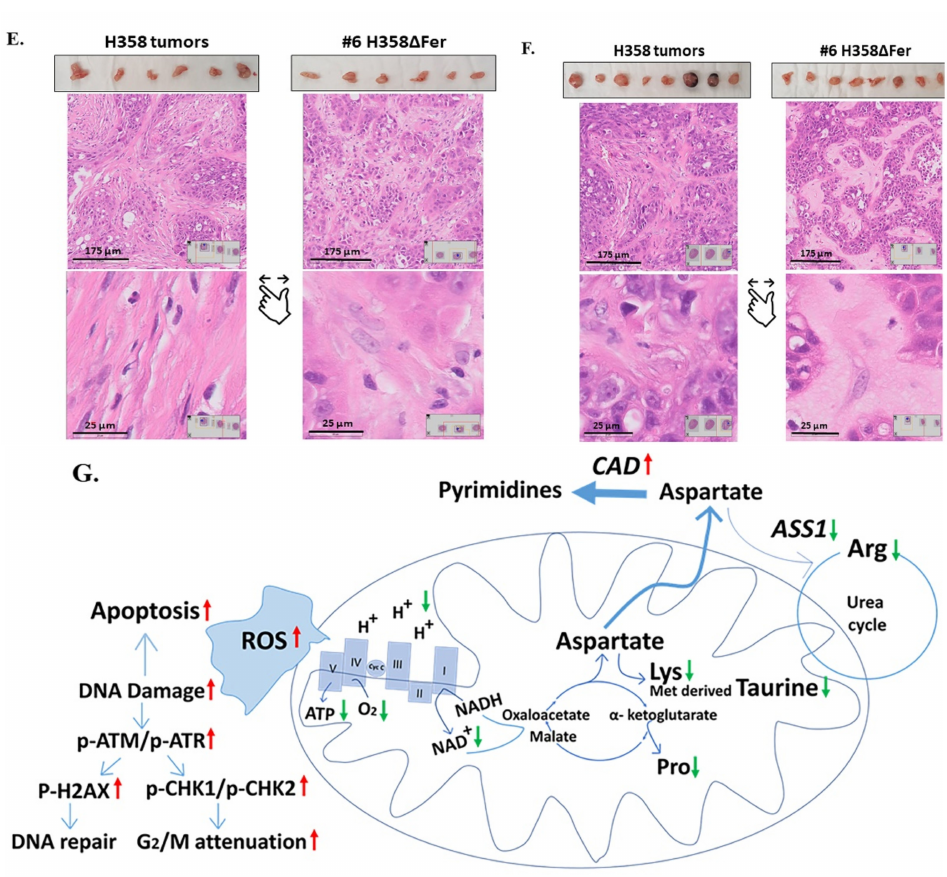
Figure 7. Absence of Fer impedes the development of BAC-NSCLC H358 and TNBC MDA-MB-231 xenografts in mice. Tumor-growth profiles, body-weight graphs of mice, and representative pictures of mice carrying tumors of ( A , B ) H358 and H358 ∆ Fer (clones #6, #7) cells and ( C , D ) MDA-MB-231 and MDA-MB-231 ∆ Fer (clones A6, A20, A32) cells, in mice fed with ( A , C ) a regular ad libitum unrestricted diet, or ( B , D ) a carbohydrate-deficient ketogenic diet. Values shown represent means +/- SE ( n = 8). ( E ) Hematoxylin and eosin staining of H358 and H358 ∆ Fer sections derived from tumors in mice fed with an ad libitum unrestricted diet, or ( F ) a carbohydrate-deficient ketogenic diet. Scale bar: 200 µ m. ( G ) Summarizing scheme depicting the supportive role of Fer in sustaining the metabolic plasticity of H358 NSCLC and MDA-MB-231 TNBC cells. Shown are mitochondrial enzymes and metabolites which are upregulated (red arrows) or downregulated (green arrows) in Fer-deficient